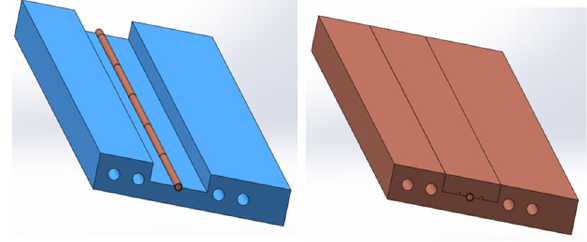
(1).FIG. 3. Brazing assembly of the 0.5-meter-long waveguide.